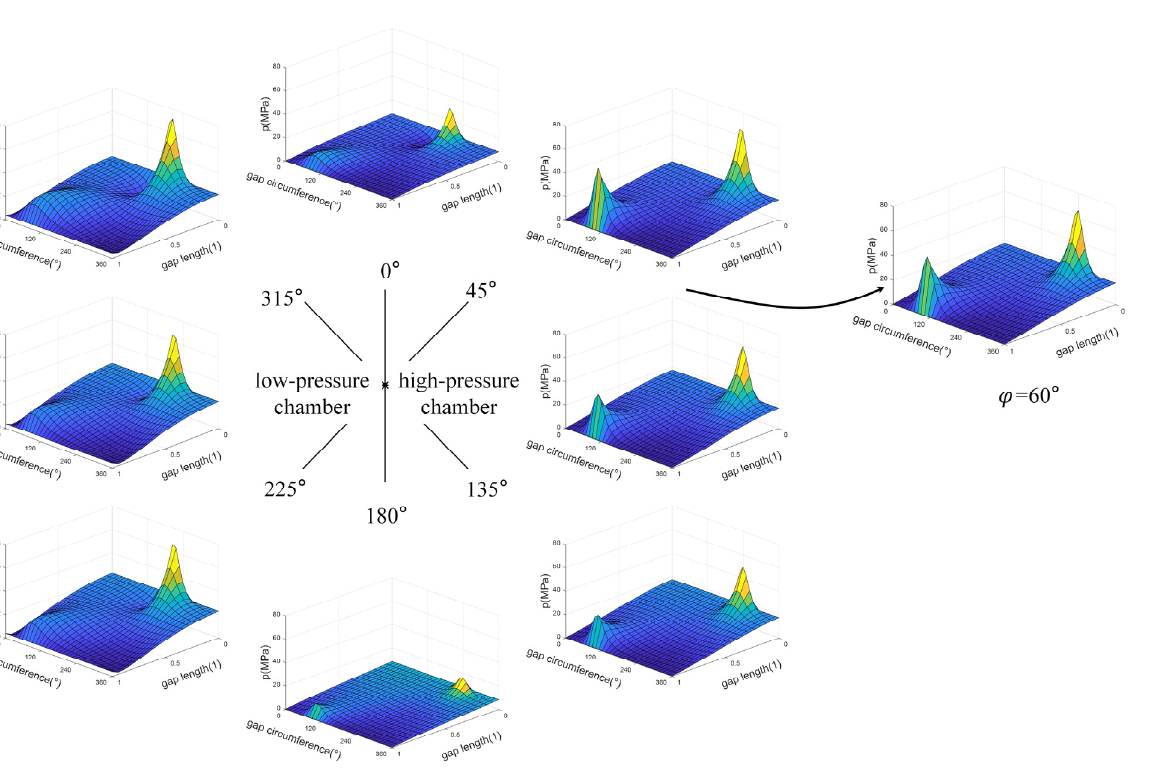
( c ) Figure 13. Comparison of the leakage of the piston–cylinder interface: ( a ) Condition 1; ( b ) Condition 2; and ( c ) Condition 3.